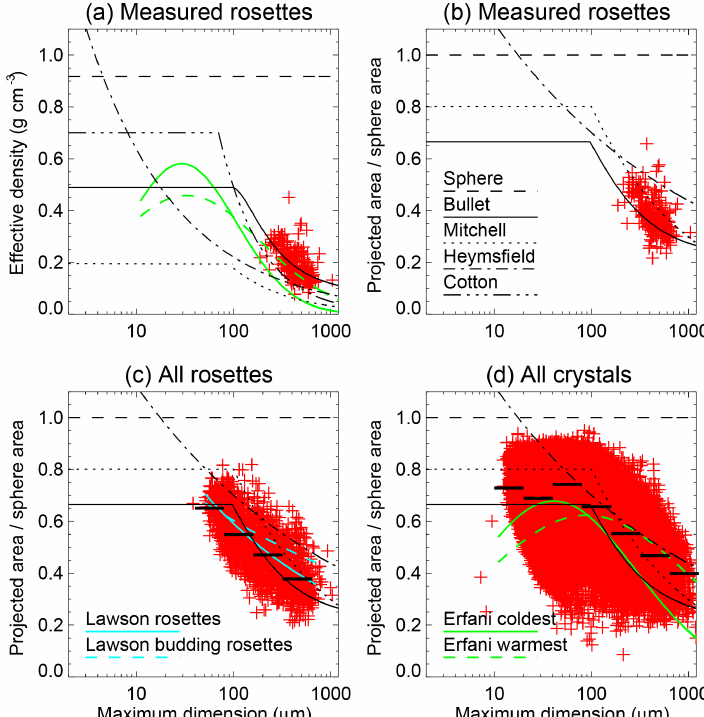
Figure 5. Bullet model: measured and calculated properties of imaged ice crystals (red symbols) emphasizing the transition to the smallest sizes. Effective density and projected area for bullet rosettes with ICR measurements (a, b) , and projected area for all bullet rosettes identified ( c , including those not measurable with the ICR software), and for all crystals imaged during the 1–2 April flights (d) . Within D max doubling bins, the median of measurements is shown where a bin contains more than 100 measurements (thick solid line segments, c and d only). Other line types indicate derived ice properties as follows (see legend in panel b ): a sphere, a six-arm bullet rosette per the bullet model (see Sect. 4.1 and Appendix A1), five-arm rosettes from Mitchell et al. (1996), and cirrus crystals from Heymsfield et al. (2002) and Cotton et al. (2012). Also shown (see legends in c and d): fits to measured areas of bullet rosettes and budding bullet rosettes from Lawson et al. (2006a), and polynomial fits from Erfani and Mitchell (2016) for synoptic cirrus crystals at − 55 to − 65 ◦ C (coldest range fitted) and − 20 to − 40 ◦ C (warmest; see